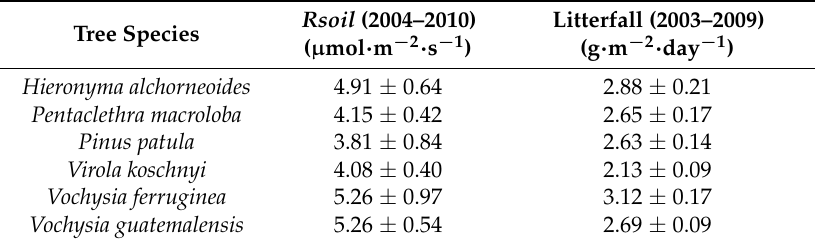
Table 2. Annual average ( ± 1 S.E.) rates of daytime soil respiration ( Rsoil ) and litterfall in experimental plantations of evergreen trees at La Selva, Costa Rica during this study. Means are weighted by days per month; and standard errors reflect variation among months. Both fluxes varied significantly among the plantation types.